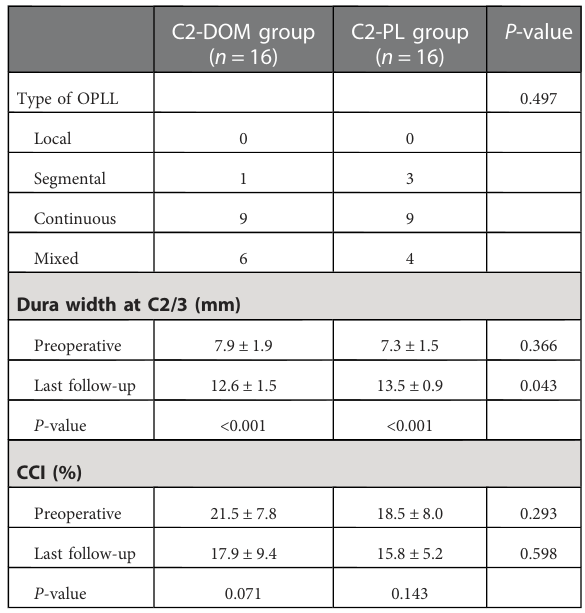
TABLE 3 Comparison of clinical outcomes between C2-DOM group and C2-PL